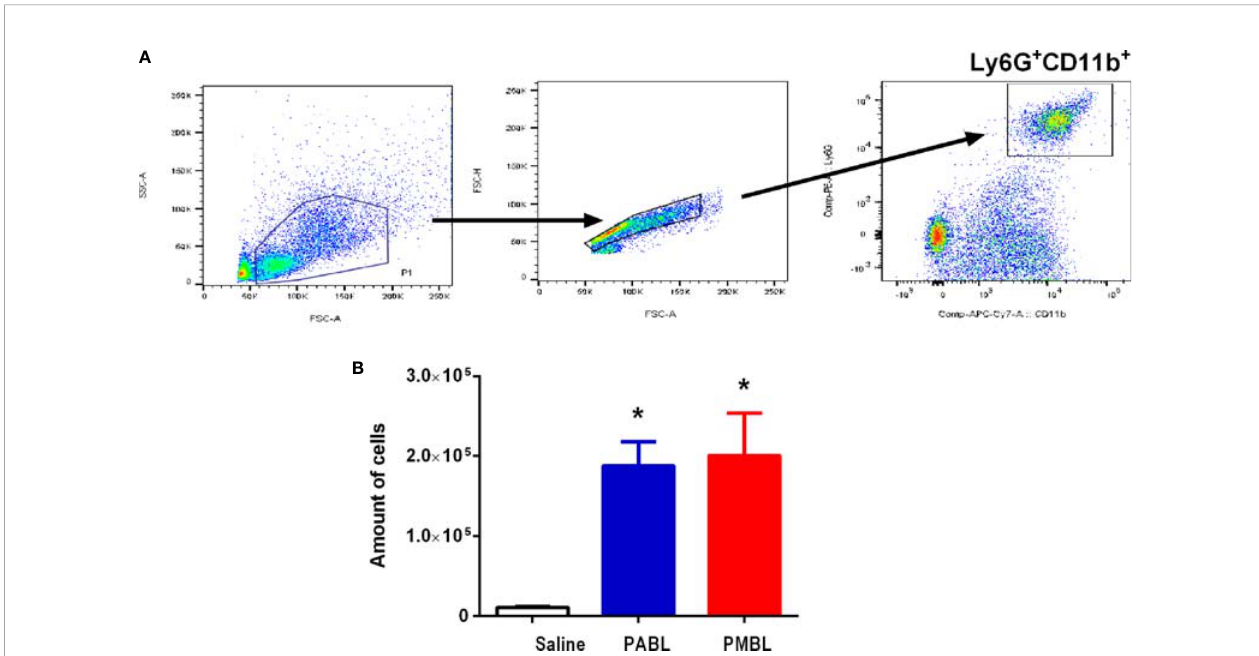
FIGURE 3 | Neutrophils from the bronchoalveolar lavages (BAL) were obtained from mice pre- treated with the polyvalent lysates. Mice (n=6) were given i.n. PABL, PMBL (6 m g/30 m l) or saline and sacri fi ced 24 h later. (A) Gating strategy; neutrophils were de fi ned by forward scatter area (FSC-A) and side scatter area (SSC-A) pro fi le, doublet discrimination, and high expression of CD11b+ and Ly6G+. (B) Bars represent Mean ± SEM of BAL neutrophils for each group. Signi fi cant differences are indicated by *p < 0.05, treated vs. untreated group, one-way ANOVA. Data are representative of three independent